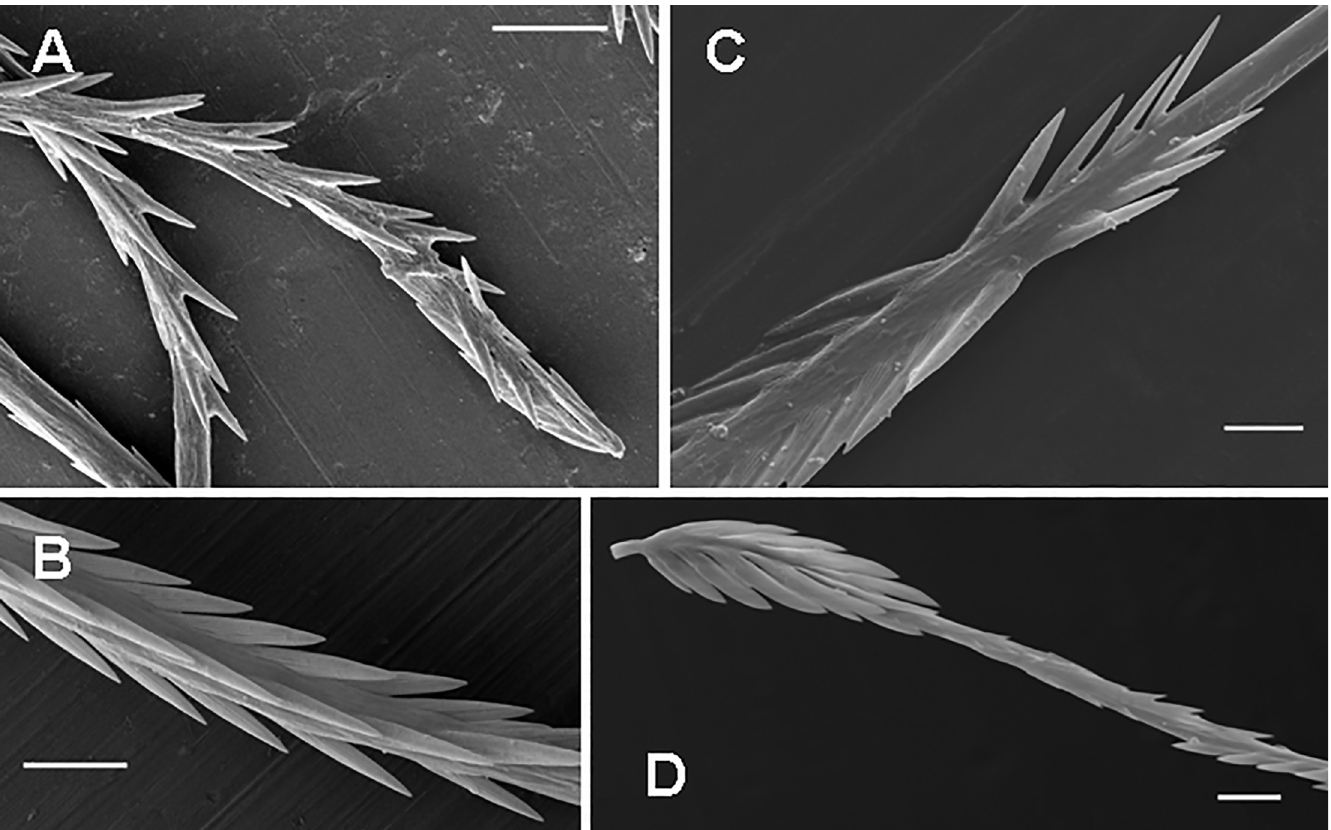
Fig 5. Urticating setae of type I and its subtypes I b and I d . (A) Aenigmarachne sinapophysis , male holotype. Type I, subtype I b , basal section with barbs reduced both in number and size. (B) Aphonopelma seemanni , male. Type I, subtype I b , midsection with three rows of reversed barbs. (C) Reversopelma petersi , male. Type I, distal end of the midsection (section C1) with a few pairs of non-reversed barbs. (D) Citharacanthus longipes , female. Type I, subtype I d , detail of the basal section and section C2. Scale bar = 10 μ